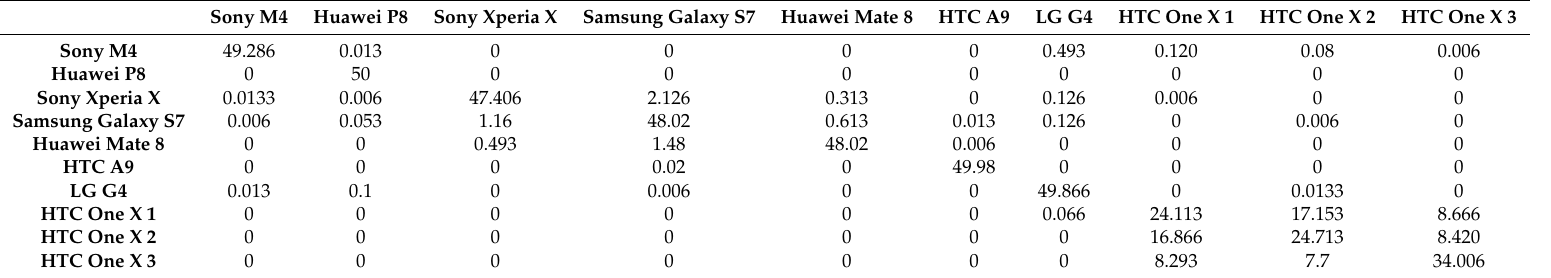
Table 8. Confusion matrix using all axes of the